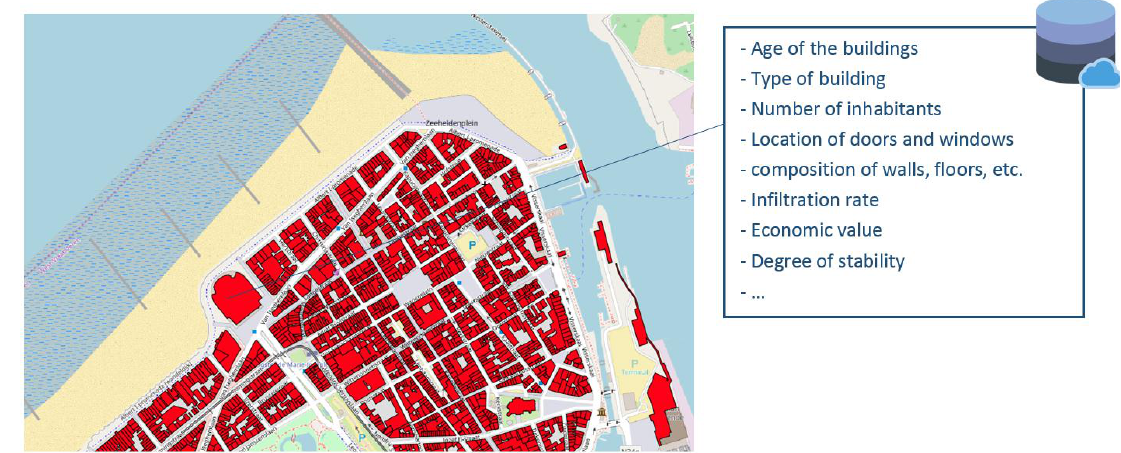
Figure 6. The flood impact assessment tool (FLIAT) comes with a relational database that can embed multiple detailed data sets.